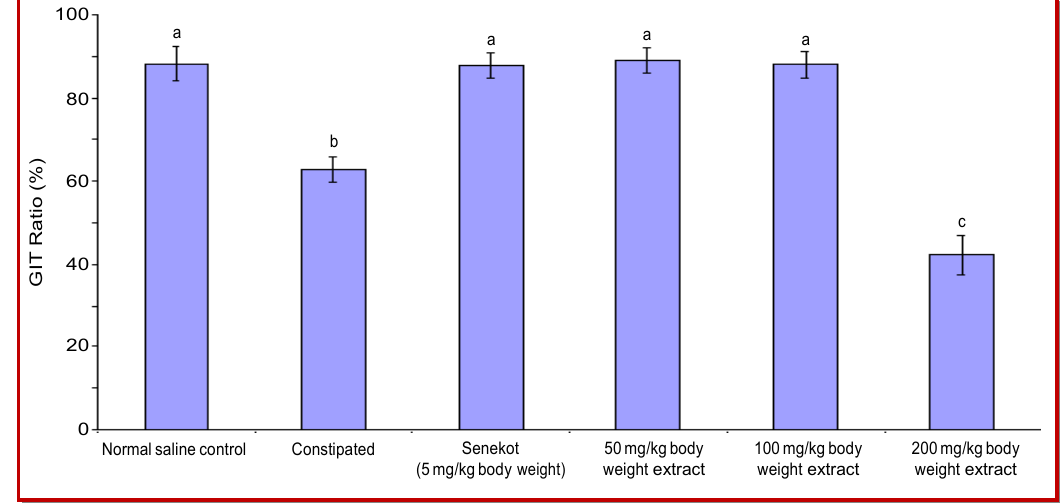
Figure 1: GIT ratio of C. penduliflorus seed extract-treated constipated